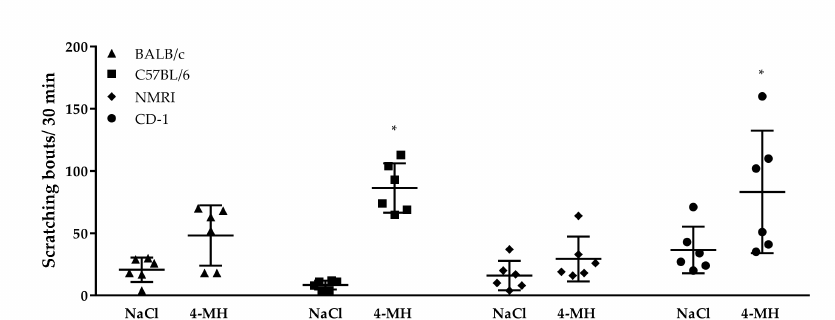
Figure 1. Strain differences in sensitivity to itch induced by 500 nmol/L 4-methylhistamine. Both BALB/c and NMRI mice did not show a significant increase in scratching response to intradermal 4-MH injection, whereas 4-MH induced a significant scratching response in C57BL/6 and CD-1 mice. Observation time: 30 min. Results are shown as scatter-dot plot with mean ± SD. n = 6, * p < 0.05 (Mann–Whitney U test) = significantly different from vehicle control (saline) injection.